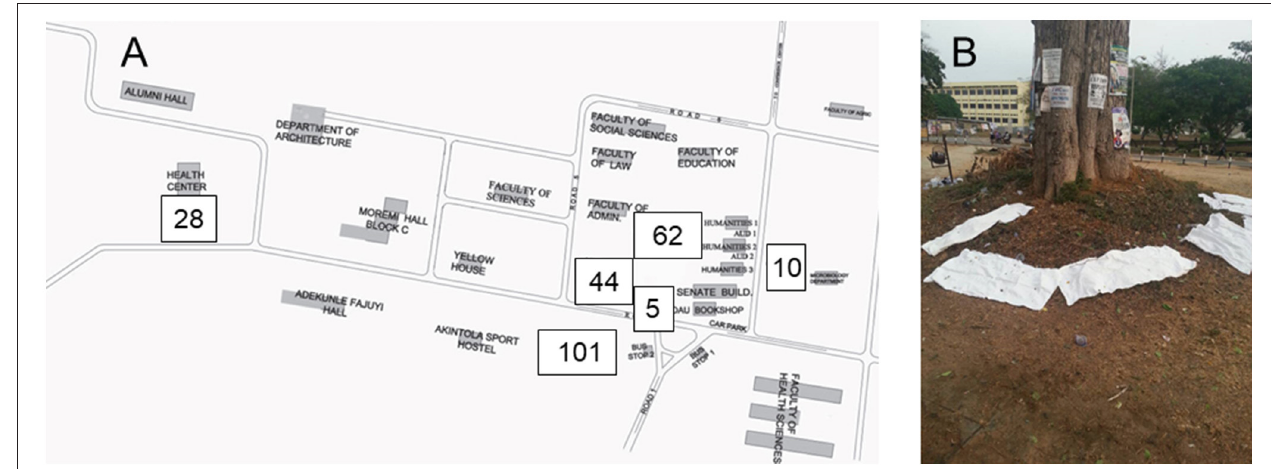
FIGURE 1 | Collection of feacal samples. Samples were collected at six sites on the Obafemi Awolowo University campus in Ile-Ife, Nigeria (A) . The number of samples are indicated for each sampling site. For the collection of samples, sterile cotton materials (36 × 45 inches) were placed under roosting sites of Straw Colored Fruit Bats ( E. helvum , B) . Swabs from feacal droppings were screened for Staphylococcus aureus